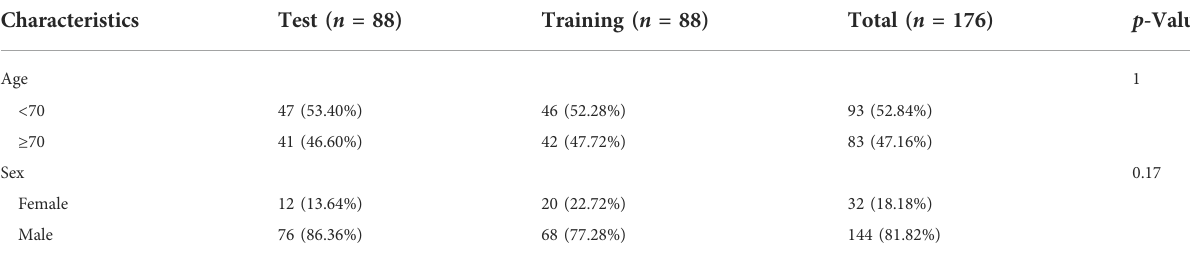
TABLE 1 The clinical characteristics of different